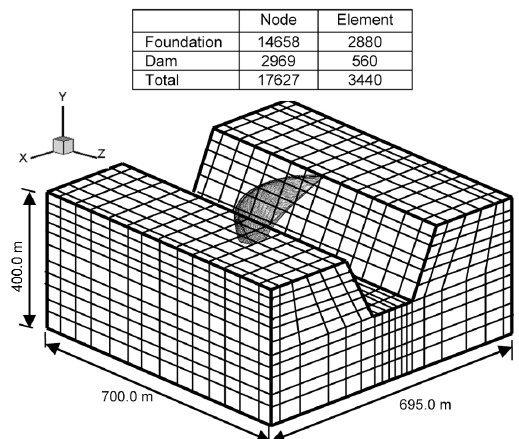
Fig. 5. Temperatures distribution for the crown cantilever of the central